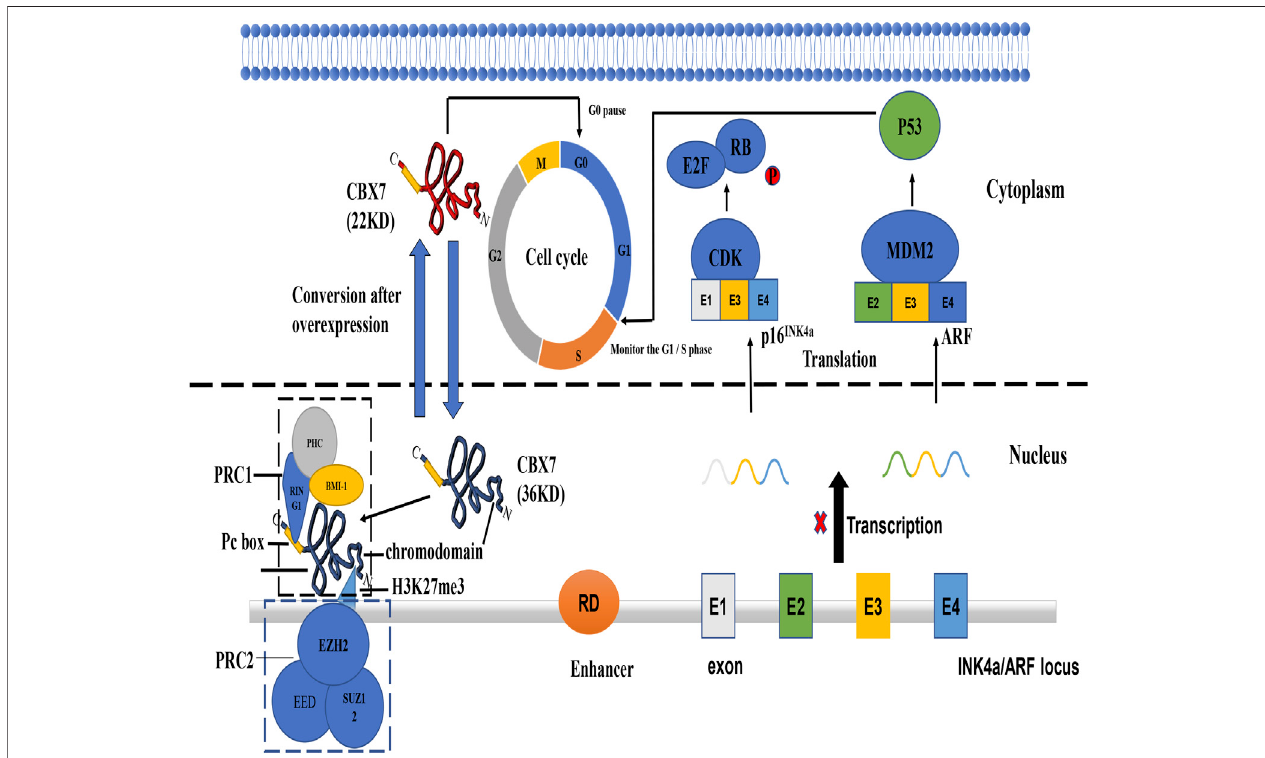
FIGURE 1 | The mechanism of tumor suppressor gene INK4a/ARF and functions of different CBX7 isoforms. (Kim and Sharpless, 2006) INK4a/ARF can express twoco-exonproductsp16andARF.P16 INK4a caninhibitthephosphate ofRBproteinbyinteractingwithcycle-dependentkinase.InactivationofCDK4/6promotesRb/ E2F1 association triggering G1/S transition. ARF can bind toMouse Double Minute 2protein (MMD2) protein toinactivate it,thereby releasingits inhibitory effect on p53 protein. P36CBX7 inhibits the expression of ARF in the nucleus to cause p53 protein abnormalities and make the cell cycle out of control at the G1/S regulatory point.P22CBX7interactswithrelatedproteinsinthecytoplasmtokeepthecellcycleintheG0phase.Bothhaveoppositeeffectsoncellproliferation,showingtheduality of